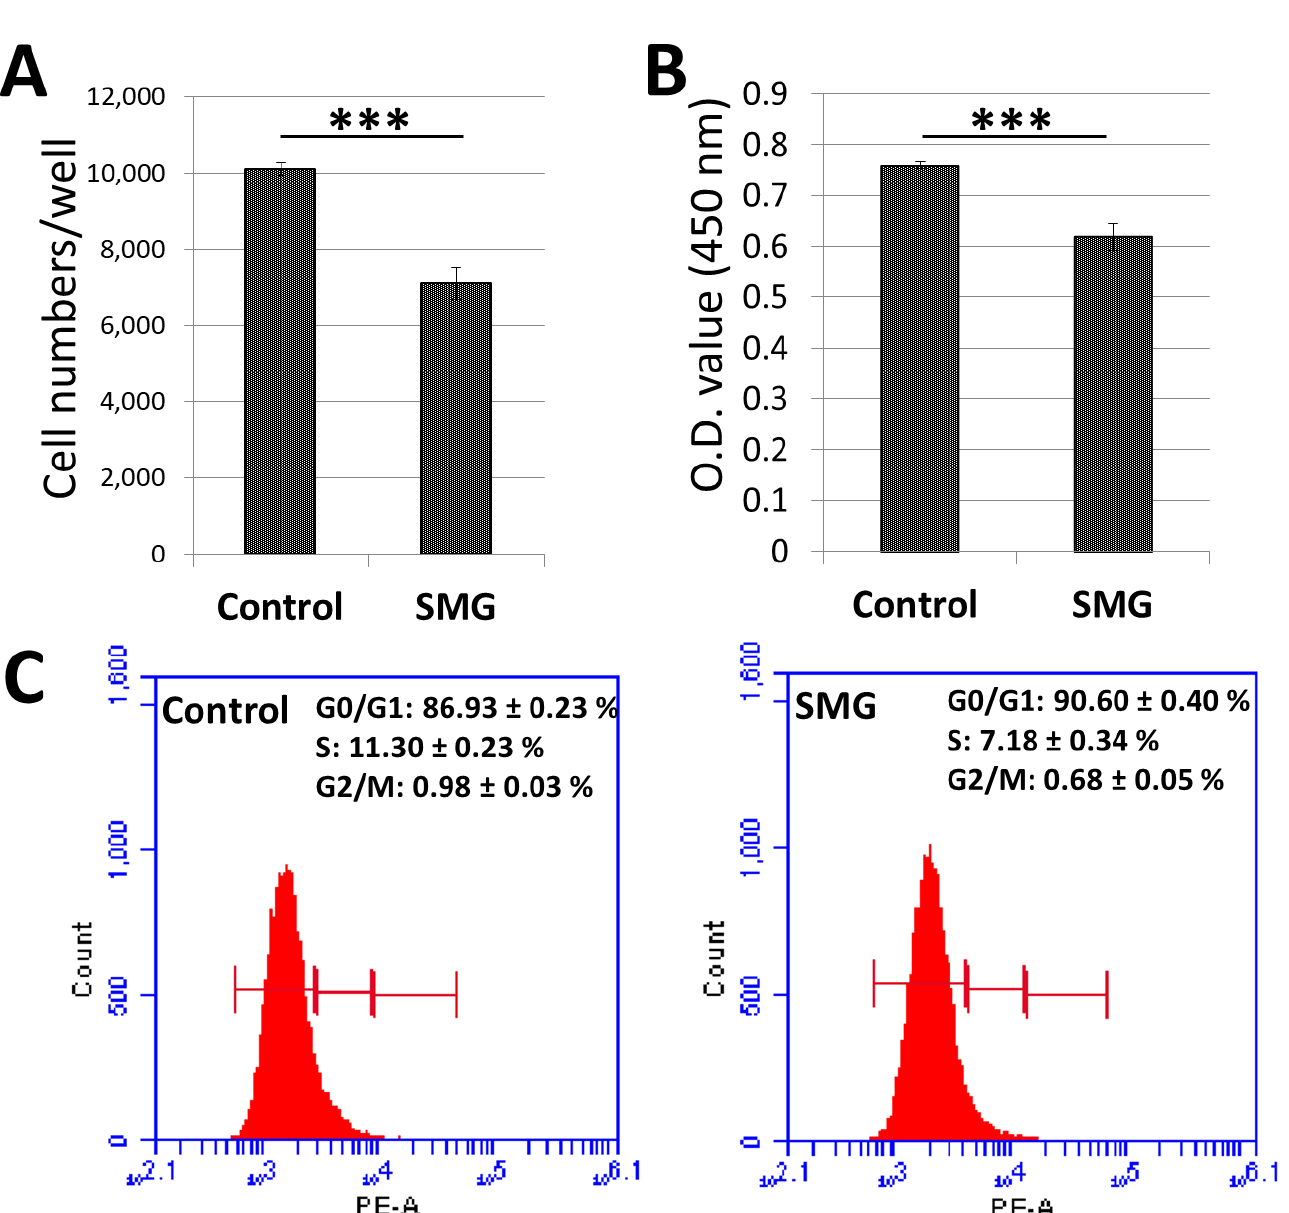
Figure 1. Proliferation of Chang Liver Cells (CCL-13) cells in control and simulated microgravity (SMG) groups. ( A ) The number of CCL-13 cells was counted using the Cell Cycle App. of the Cytell microscope ( n = 12). ( B ) CCL-13 cell proliferation was assessed by WST-1 assay ( n = 12). ( C ) Cycle progression of CCL-13 cells was analyzed by flow cytometry ( n = 4). *** indicates significant difference compared with the control group ( p < 0.001).